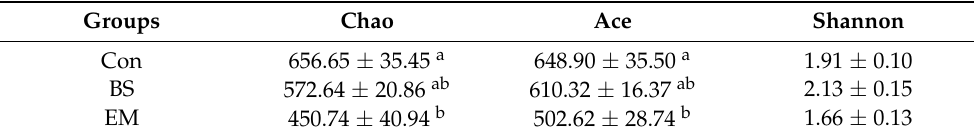
Table 5. Effects of probiotics on intestinal microbial diversity of M. rosenbergii